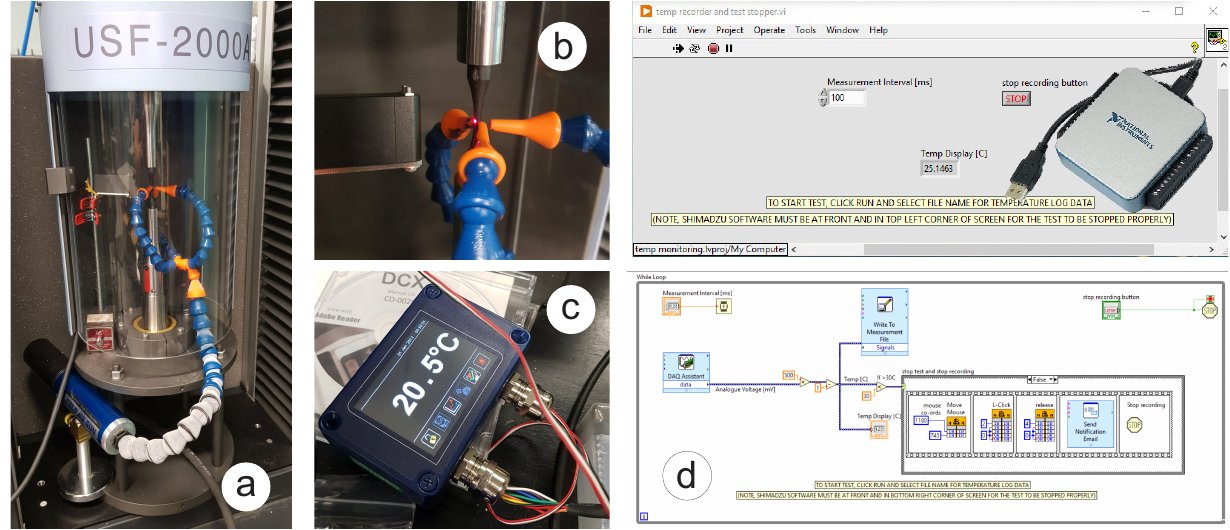
Figure 1. Modified arrangement for temperature control of the ultrasonic test: ( a ) USF-2000A with mean stress loading mechanism and VORTEC cold air gun; ( b ) Pyrocube IR temperature sensor; ( c ) touch screen display for PyroCube; ( d ) NI USB Multifunction DAQ data acquisition card and LabView